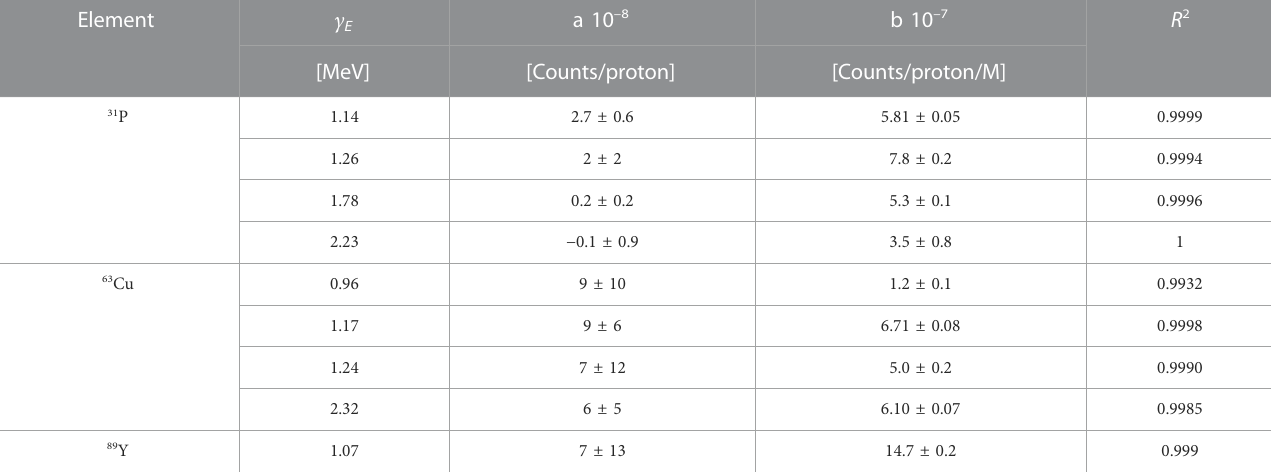
TABLE 3 Parameters obtained by fi tting the experimental data of Figure 9 with a linear function y = a + b x . Element